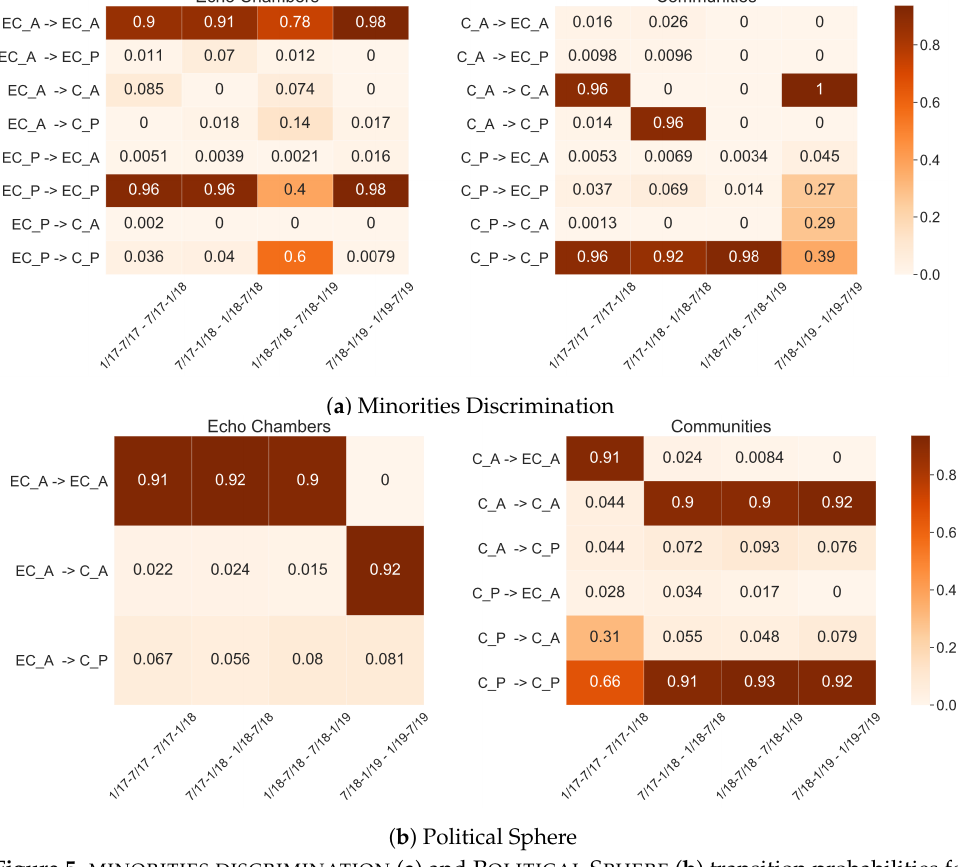
Figure 5. MINORITIES DISCRIMINATION ( a ) and P OLITICAL S PHERE ( b ) transition probabilities for echo chamber ( EC ) and communities ( C ) over contiguous